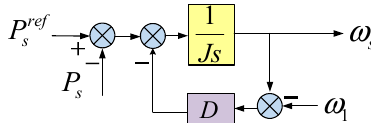
Figure 1. Active power-frequency control loop of virtual synchronous generator (VSG).